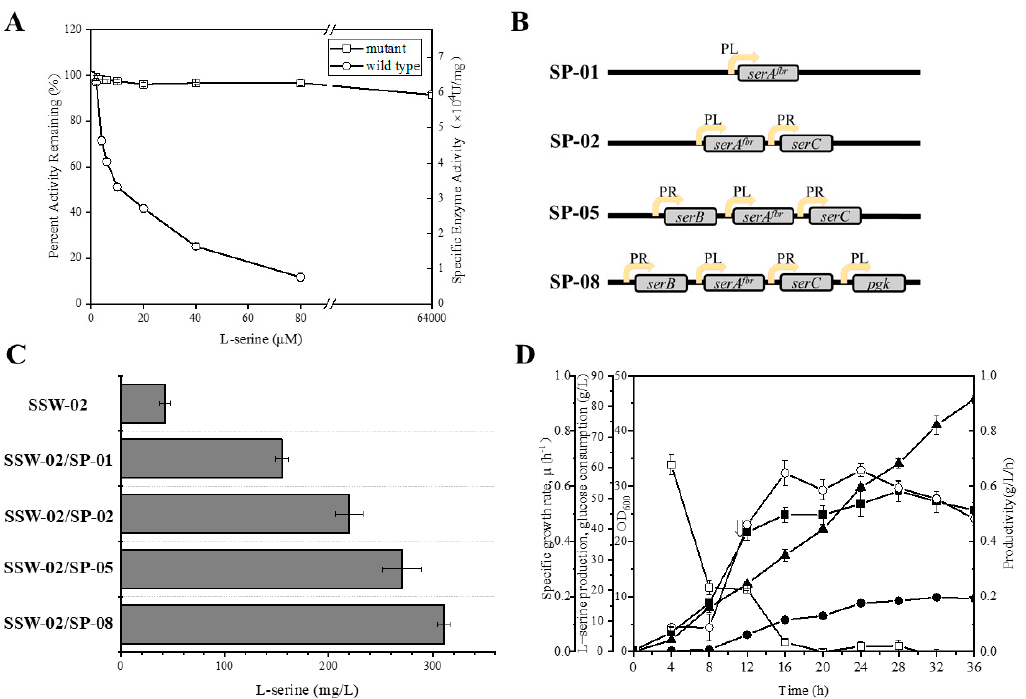
Figure 2. Optimization of the synthetic serA fr CB operon with pgk and screening for high-level L-serine production. ( A ) PGDH mut ( serA fr , open squares), PGDH wt ( serA , open circles). ( B ) The structure of different plasmids. The yellow arrow with PR or PL indicates PR or PL promoters. ( C ) L-serine production by shake flask fermentation with different plasmids. ( D ) L-Serine production by SSW- 02/SP-08 by fed-batch fermentation. Cell growth (filled squares), L-serine concentration (filled circles), glucose consumption (upward-pointing filled triangles), specific growth rate (open squares), and L-serine productivity (open circles). The arrow indicates the starting point of induction. The data are presented as the means ± SDs from three measurements.